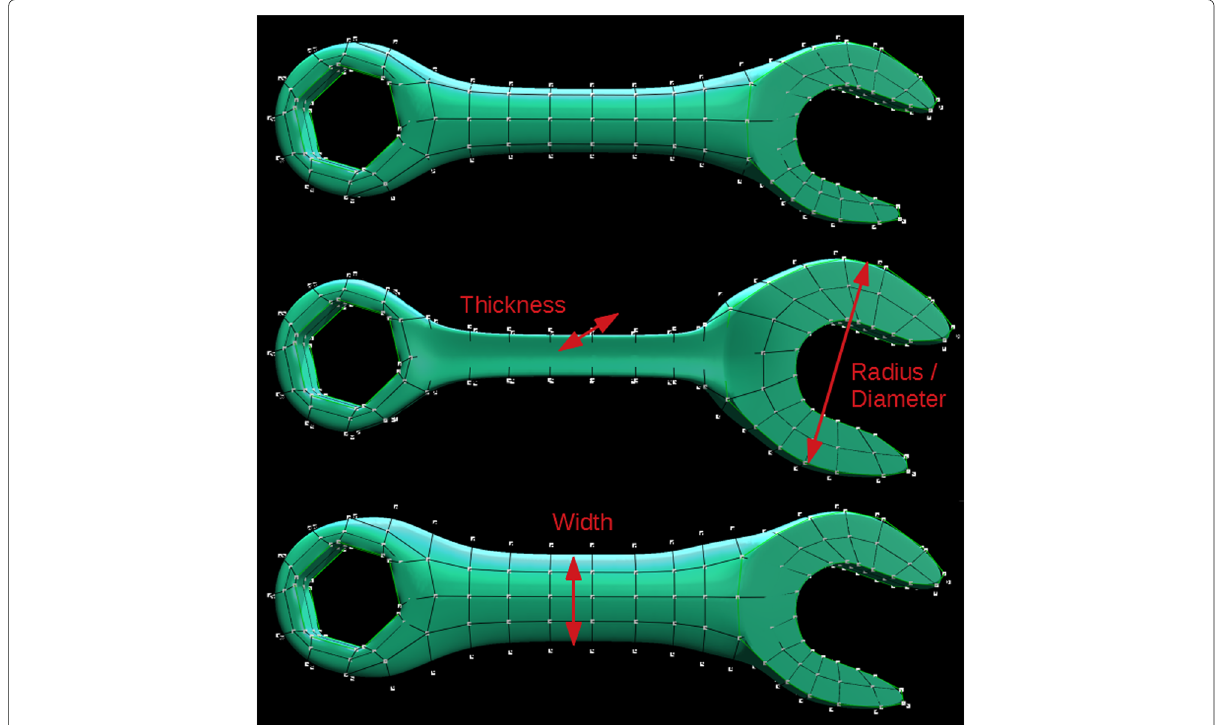
Fig. 17 Different geometry variants of the wrench model including parameters to be